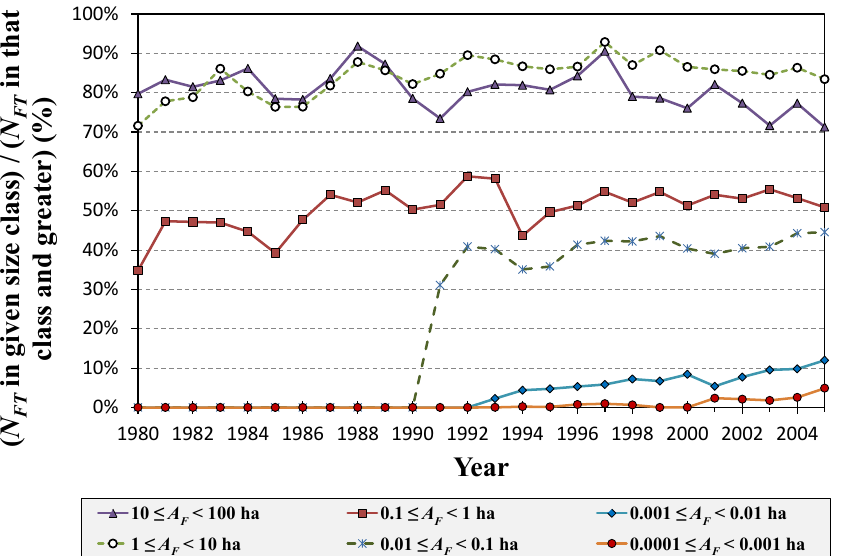
Fig. 5. Percentage of Continental Portuguese fires N FT , in specified burnt area size class (see legend), divided by all fires in that burnt area class and greater. The N FT (size class)/ N FT (size class and greater) is given as a function of year,